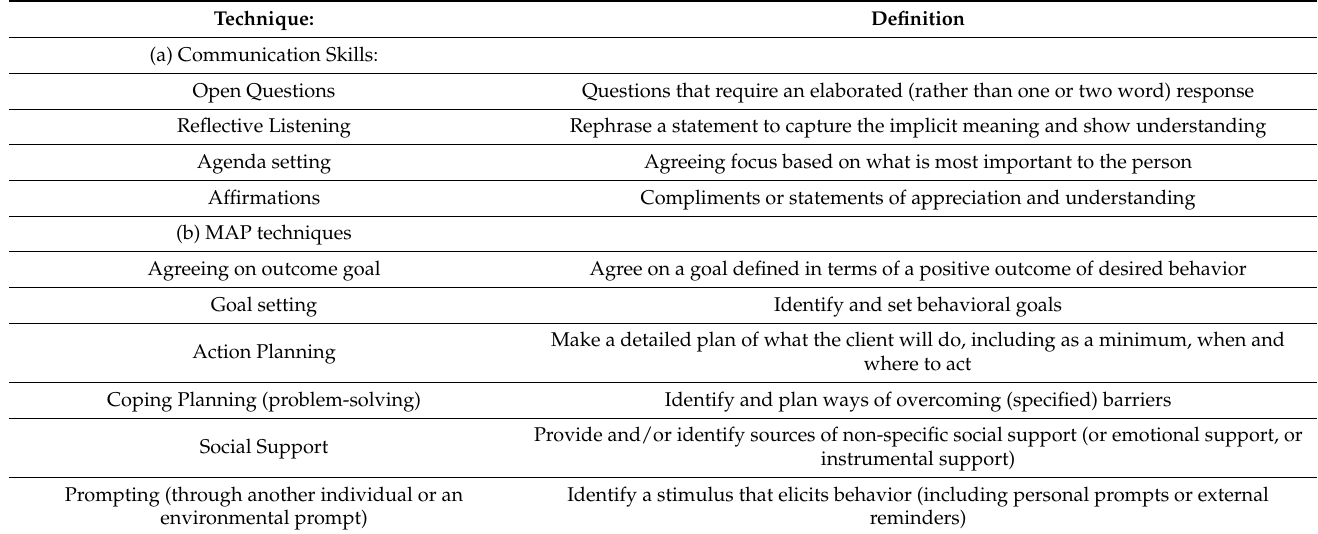
Table 1. Communication skills and MAP Behavior Change Techniques used in the training.